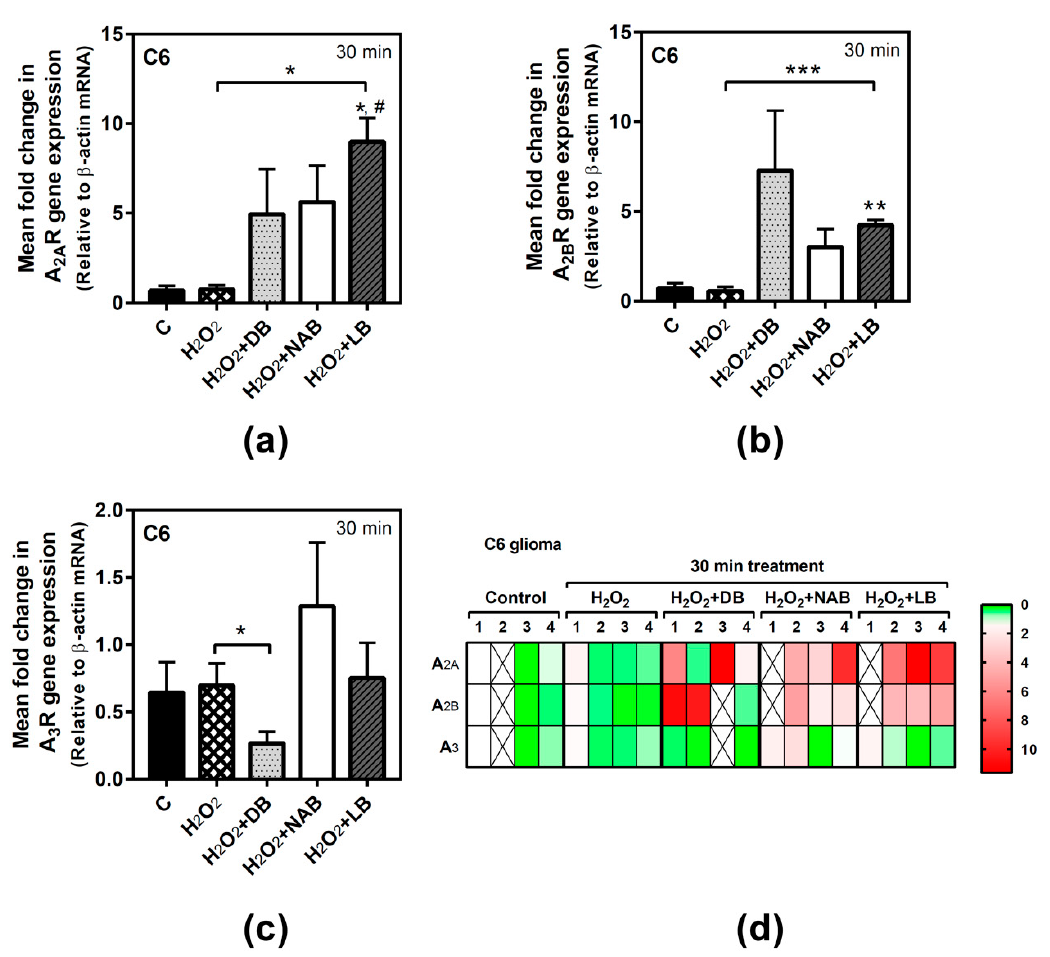
Figure 6. Adenosine receptors gene expression assayed by quantitative real-time RT-PCR in C6 cells. After total RNA isolation, A 2A (panel a ), A 2B (panel b ), and A 3 (panel c ) receptor gene expression levels were detected by TaqMan universal PCR following the protocol indicated in “Materials and Methods”. β -actin was used as an endogenous control in all assays. Treatments were performed for 30 min with 50 µM hydrogen peroxide (H 2 O 2 ) and DB, NAB, and LB extracts in C6 cells. ( d ) Heatmap of gene expression levels obtained in the analyzed samples. Data are means ± SEM of, at least, three independent assays; * p < 0.05, ** p < 0.01, and *** p < 0.001, significantly different from their corresponding control (C) or considered bars according to Student’s t test; # p < 0.05 significantly different from control (C) according to one-way ANOVA test.